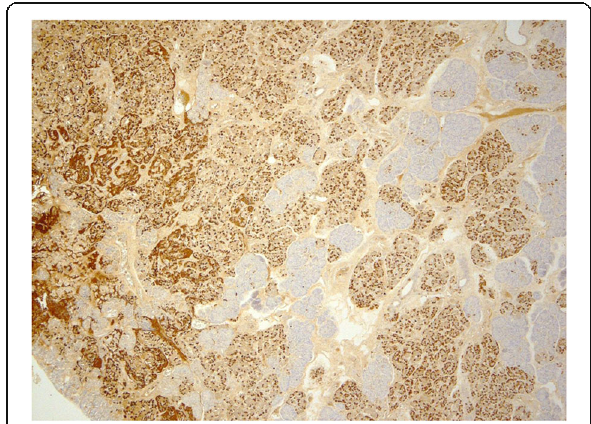
Fig. 3 Immunohistochemical staining of insulin showed increased number of insulin-positive cells in the focal lesion of the resected pancreas specimen (dyed